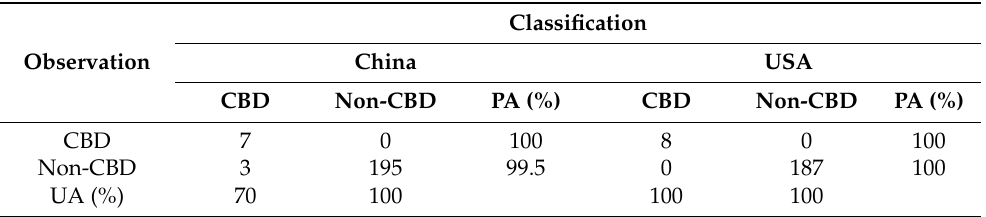
Table 5. Accuracy assessment of China rules and the USA rules. Expressed in the number of PAAs.